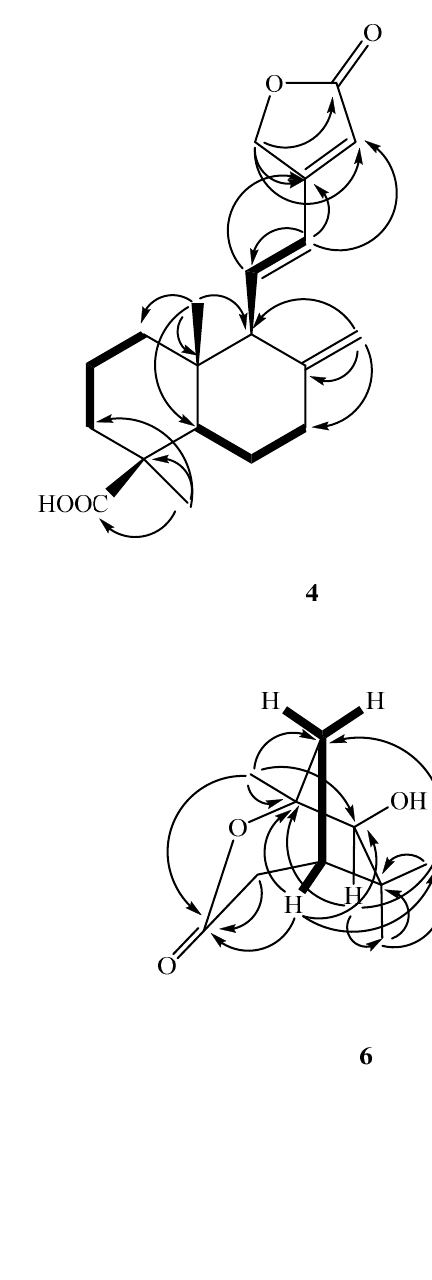
Molecules 2021 , 26 , x FOR PEER REVIEW